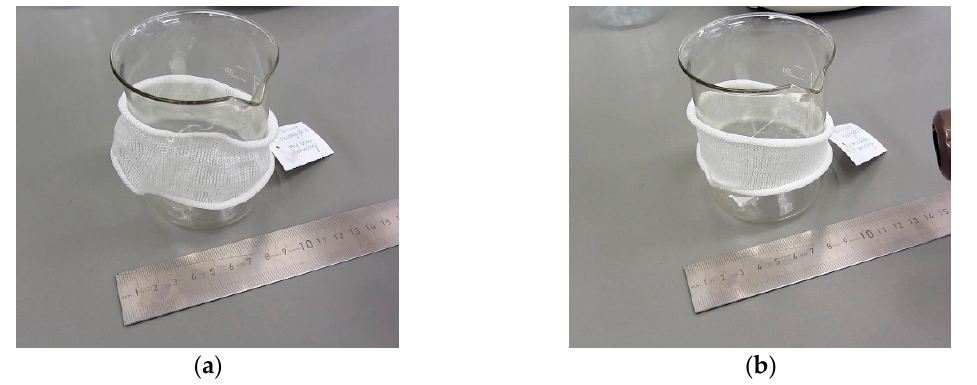
Figure 10. A knitted tube comprised of a shape memory blend yarn in widened state before stimulation ( a ) and tightened state after stimulation ( b ) (Video S1 of Supplementary Materials).